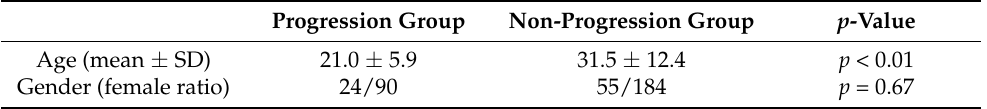
Table 1. Patients’ background.